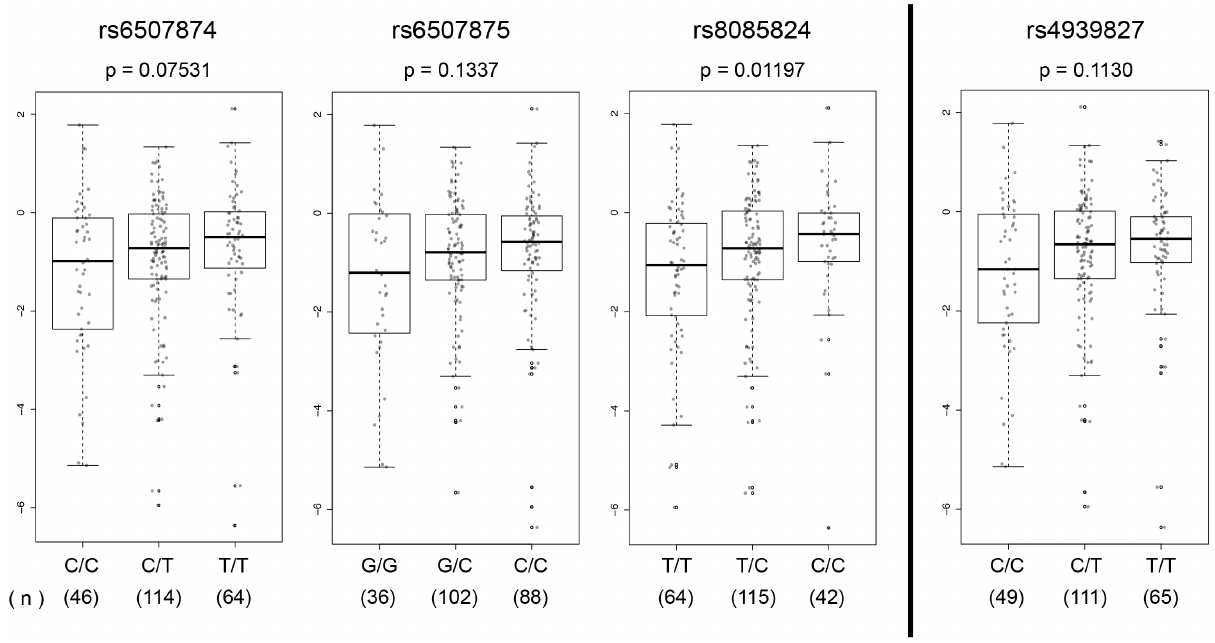
Figure 5. Candidate functional SNPs are association with SMAD7 gene expression levels. Fold change (FC) of SMAD7 expression was measured in normal colon tissue samples from surveillance colonoscopies. Rank-based non-parametric analysis was used to estimate the effect of each extra minor allele for rs6507874, rs6507875, rs8085824, and rs4939827 (additive model) on gene expression adjusting for gender, age and race. Two-sided p -values were obtained from a likelihood ratio test. Log 2 ( DD Ct) were plotted as a function of genotypes using a box plot – dot plot overlay. Number of samples is noted under each genotype. A statistically significant association was found for rs8085824.